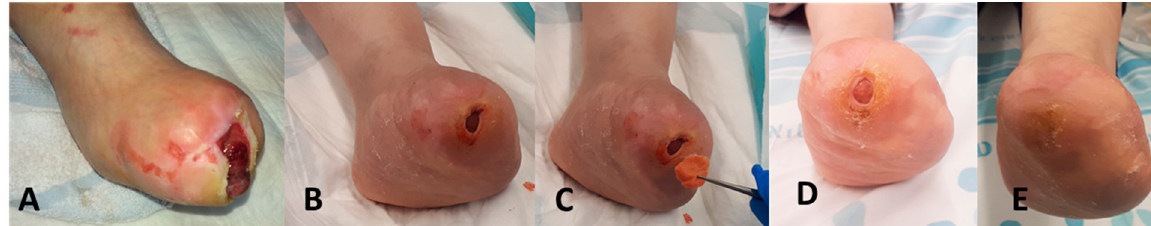
Figure 3. Closure of a 6-year indolent chronic wound in from insulin-dependent diabetes mellitus (IDDM) patient (Case Report 1). ( A ) The patient underwent a trans-metatarsal amputation in her left foot in 2013. ( B ) The wound was not closed for six years and in June 2019 the wound was about 7 mm deep with furrow (tunneling surrounding it). ( C ) On 27th June 2019 the wound was filled with COD wound dressing (WD). WD was changed every three days. ( D ) One week later the wound volume was reduced by approximately 90%. ( E ) On 10th August 2019, the wound was completely closed.